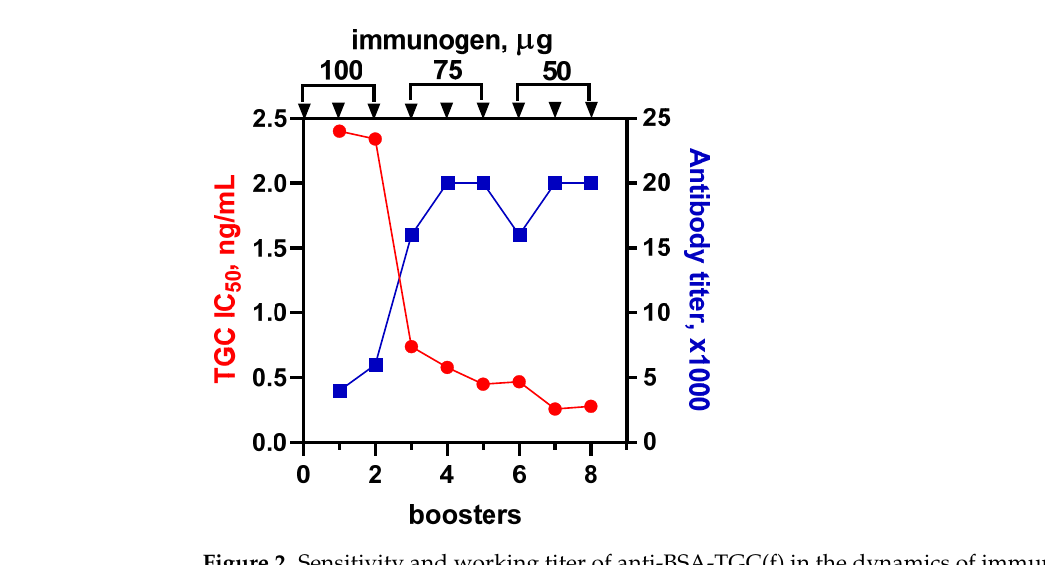
Figure 2. Sensitivity and working titer of anti-BSA-TGC(f) in the dynamics of immunization. Each titer value is represented by an average (n = 3) working dilution of the antibody, providing binding absorbance in the range of 0.8–1.2. IC50 values were calculated using the standard curves derived from corresponding antibodies. Table 1. Structural formula of tetracyclines and cross-reactivity (CR) profile of anti-BSA-TC(f) and anti-BSA-TGC(f).